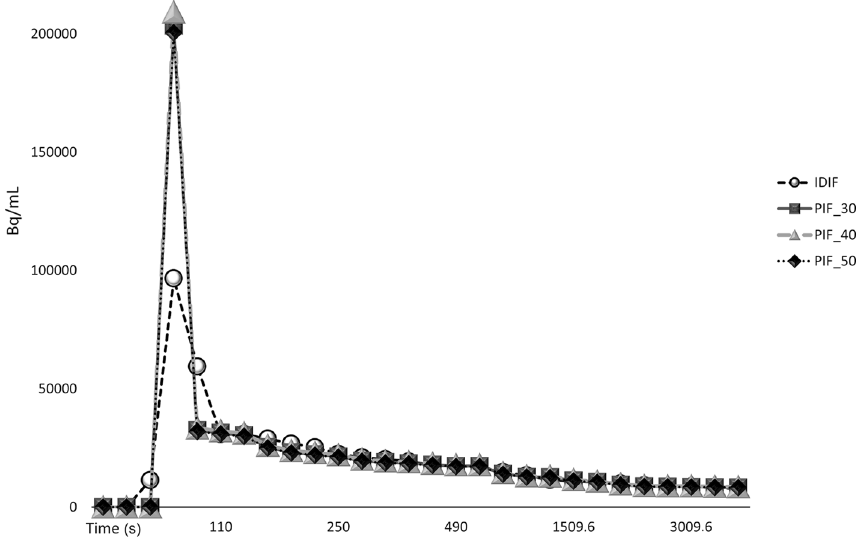
Fig. 2 Example IDIF and the PIF scaled towards the example IDIF at various shortened scan time intervals